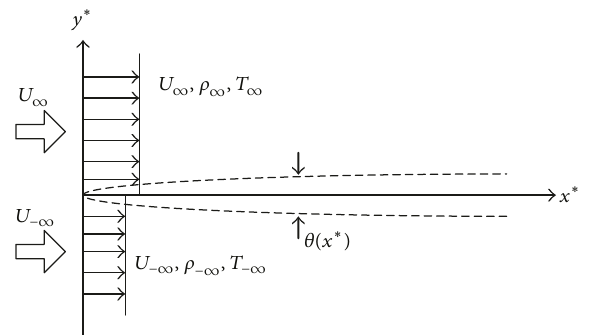
Figure 1: Schematic of a shear layer between two